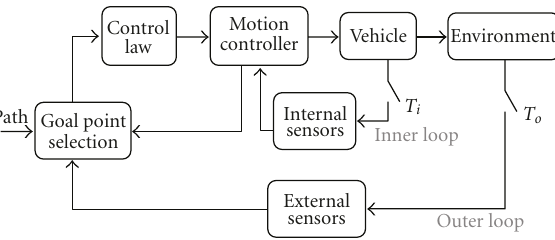
Figure 2: Block diagram of the pure-pursuit path